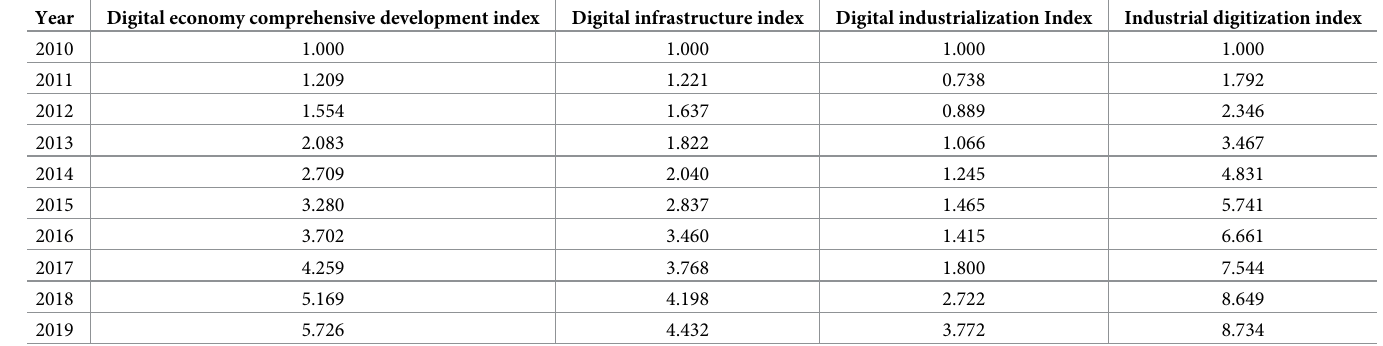
Table 3. Estimation of the digital economy development level from